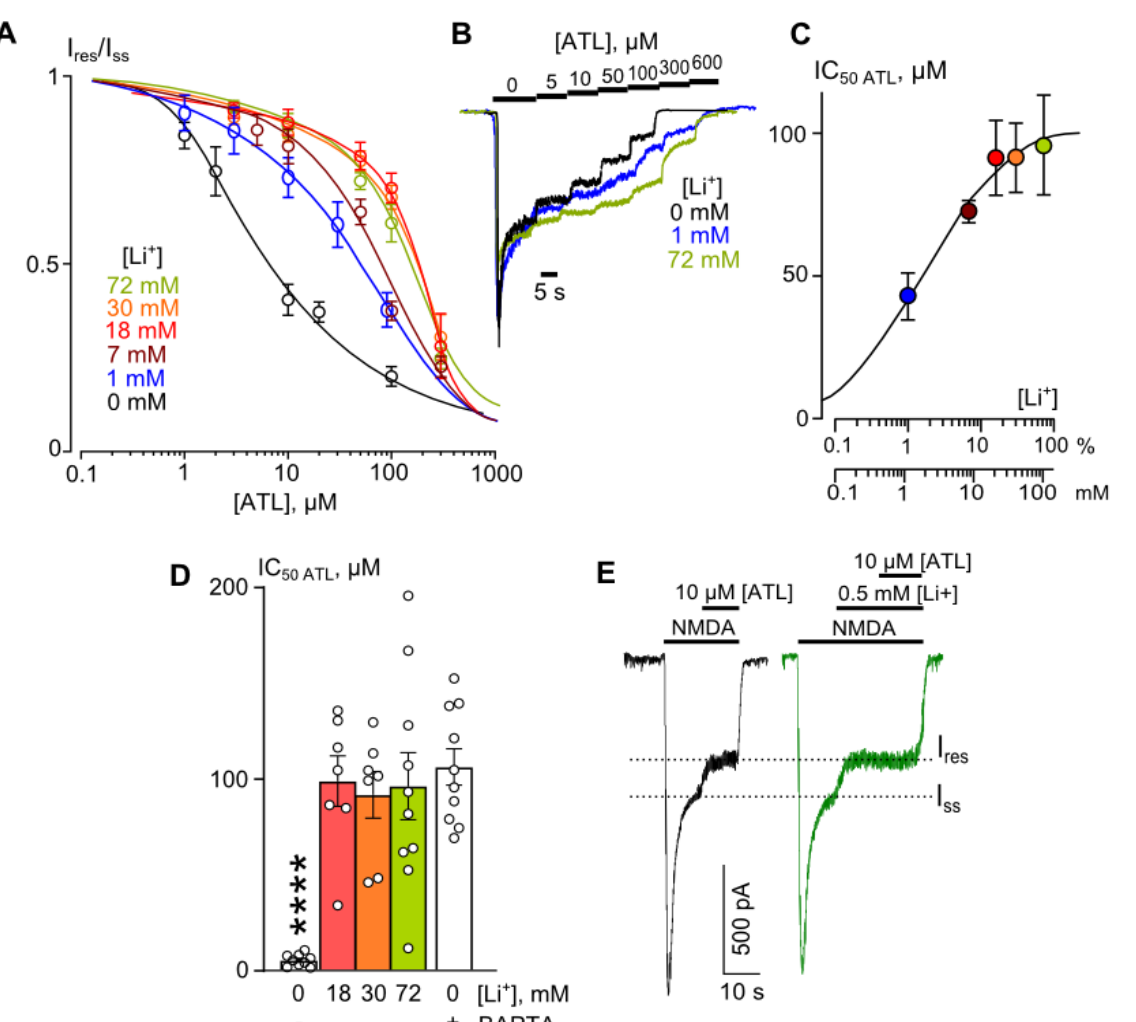
Figure 2. The effect of extracellular lithium on amitriptyline (ATL) inhibition of NMDAR currents in the bathing solution containing 2 mM [Ca 2+ ]. ( A ) Dependence of IC 50 for ATL inhibition of NMDAR currents on extracellular [Li + ]. Symbols show mean values ± S.E.M of the relative amplitudes of currents (I b /I c ) in the presence (I b ) and absence (I c ) of different ATL concentrations ([ATL]). Solid lines are the fits to the data with the Hill equation. ( B ) Examples of currents activated by 100 µ M NMDA + 30 µ M Gly recorded at − 70 mV in the presence of increasing [ATL] in the control bathing solution and in 1 or 72 mM [Li + ]. [ATL]s are indicated by numbers at the corresponding level of currents (in µ M). Currents are normalized to the steady-state amplitude without ATL. ( C ) Dependence of IC 50 for inhibition of NMDAR currents by ATL on extracellular [Li + ], obtained from experiments illustrated in panel A . The [Li + ] corresponding to 50% effect on ATL IC 50 was estimated as 1.4 ± 0.57 mM using Hill equation. ( D ) Mean IC 50 s for ATL inhibition of NMDAR currents in control, in the presence of 18–72 mM [Li + ], and in neurons loaded with BAPTA. Data in control differ significantly from those in the presence of Li + or in BAPTA-loaded neurons (****, p = 0.00001, one-way ANOVA). Data from each experiment (symbols) and mean values ± S.E.M. are shown. ( E ) Currents activated by 100 µ M NMDA + 30 µ M Gly recorded at − 70 mV in a single neuron in the bathing solution containing 2 mM [Ca 2+ ] in control and in the presence of 0.5 mM [Li + ]. 10 µ M ATL was applied at the steady state of NMDA-activated currents.